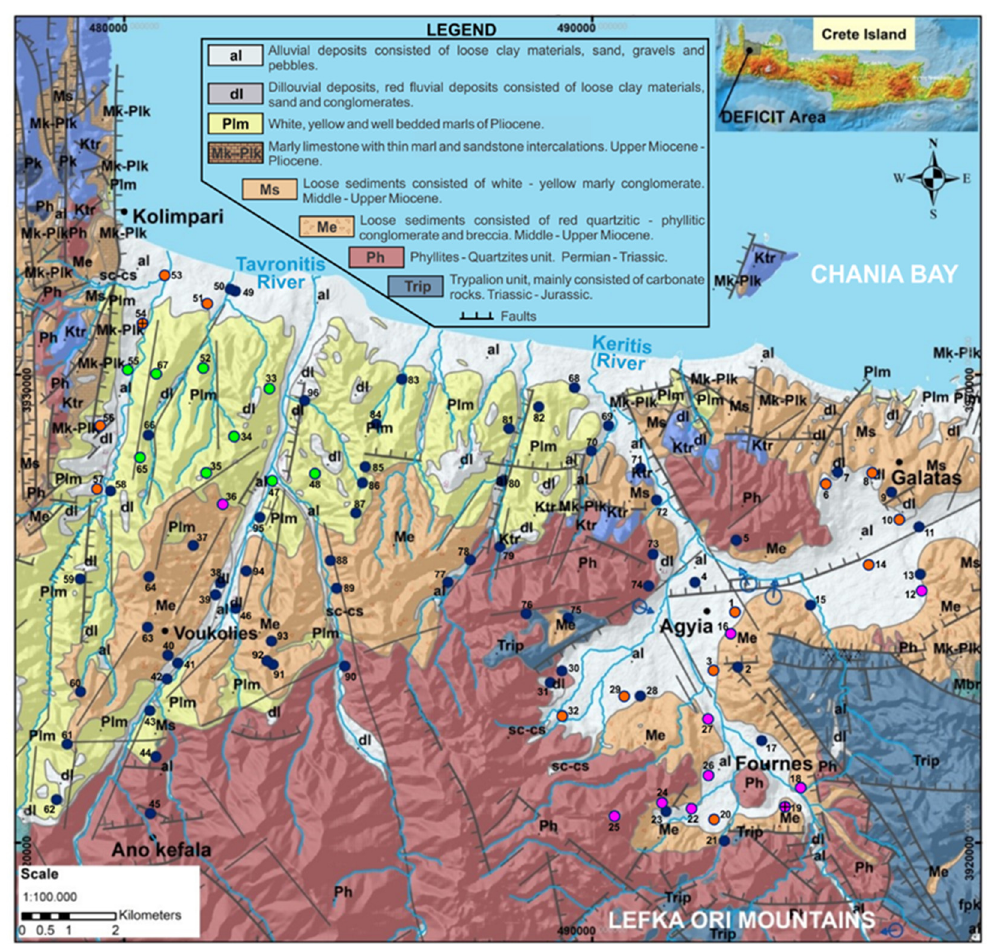
Figure 2. Geological map of the Chania Plain, modified from [50] and references therein, showing the spatial distribution of the 96 sites (colored circles). Class S1 (n = 10), S2 (n = 14) and S3 (n = 9) sites resulting from geological classification are indicated with magenta, light brown and green circles, respectively. Control points #19 and #54 are indicated by a cross in the circle.